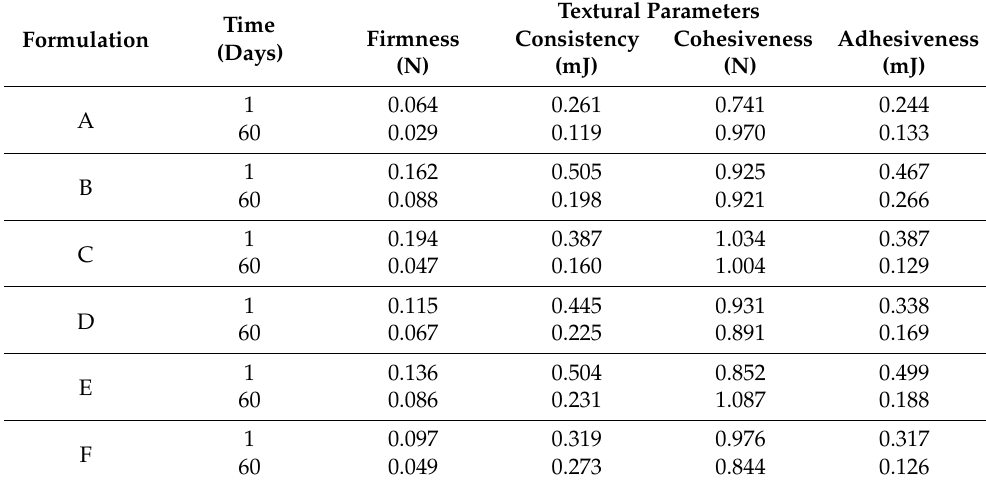
Table 3. Numerical values of the textural parameters for formulations tested of t = 1 and t = 60 at room